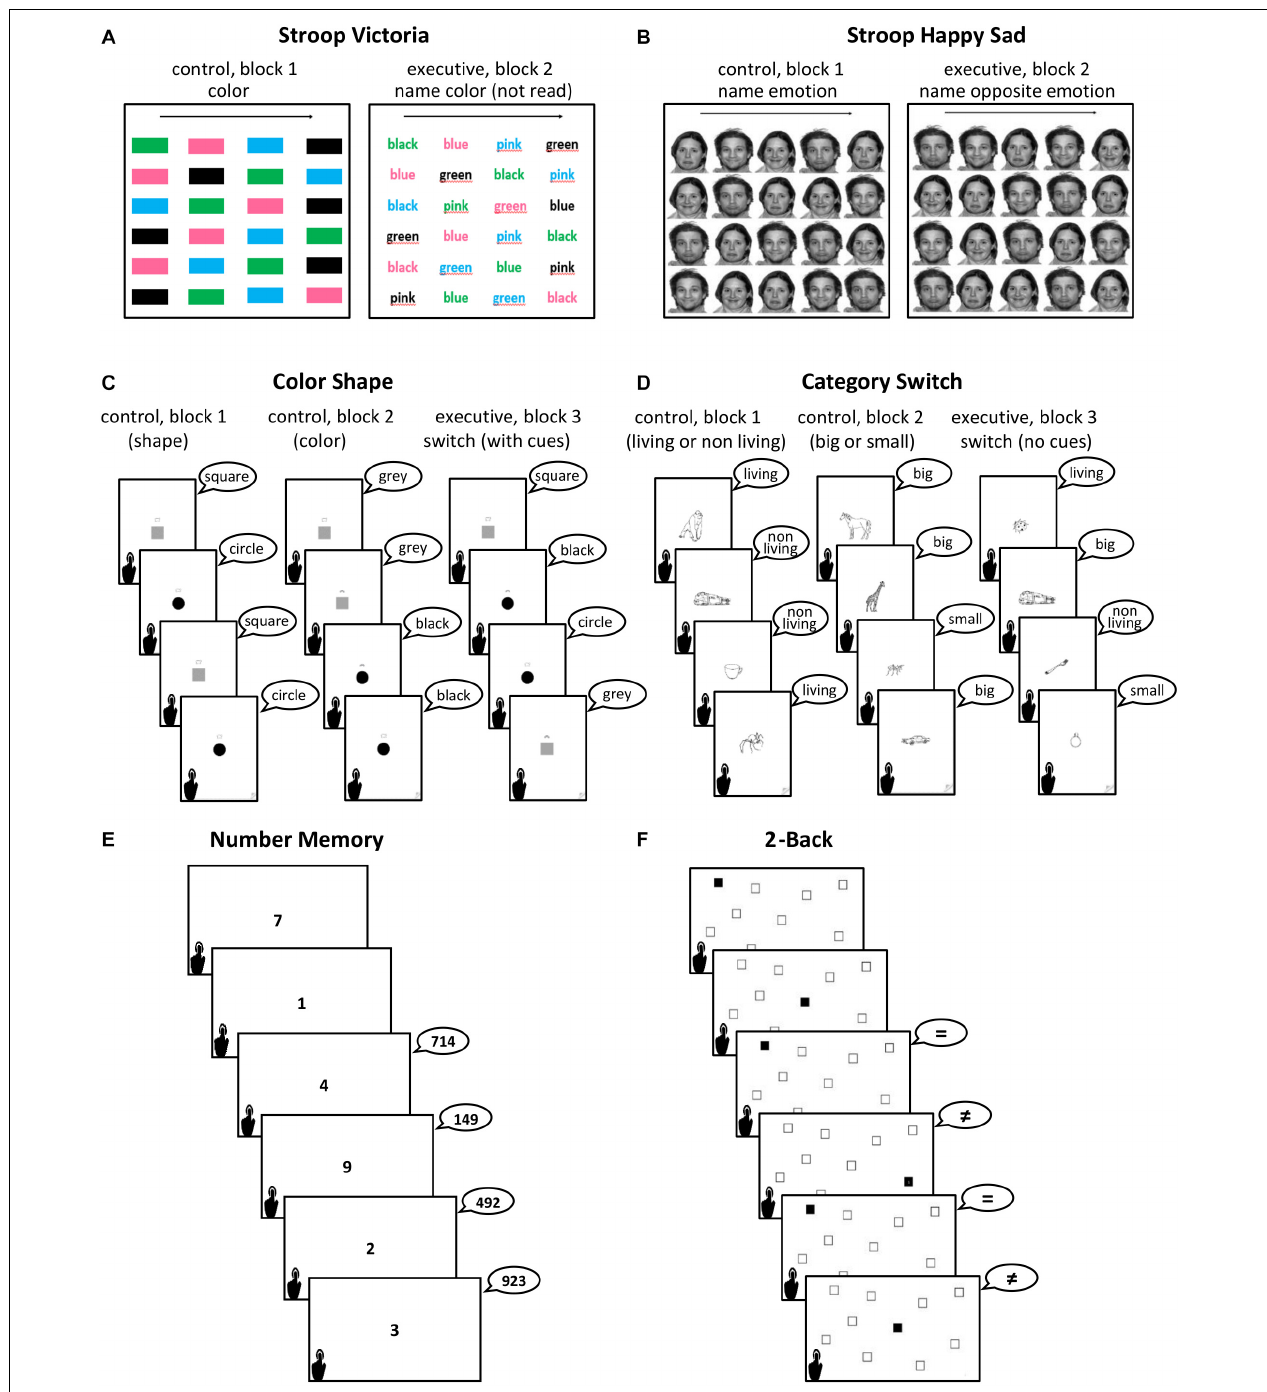
FIGURE 1 | Illustration of the two tasks of each of the three executive domains: inhibition tasks (A,B) , shifting tasks (C,D) and updating tasks (E,F) . All illustrated answers in speech bubbles are correct. See texts and Supplementary Material I for details.